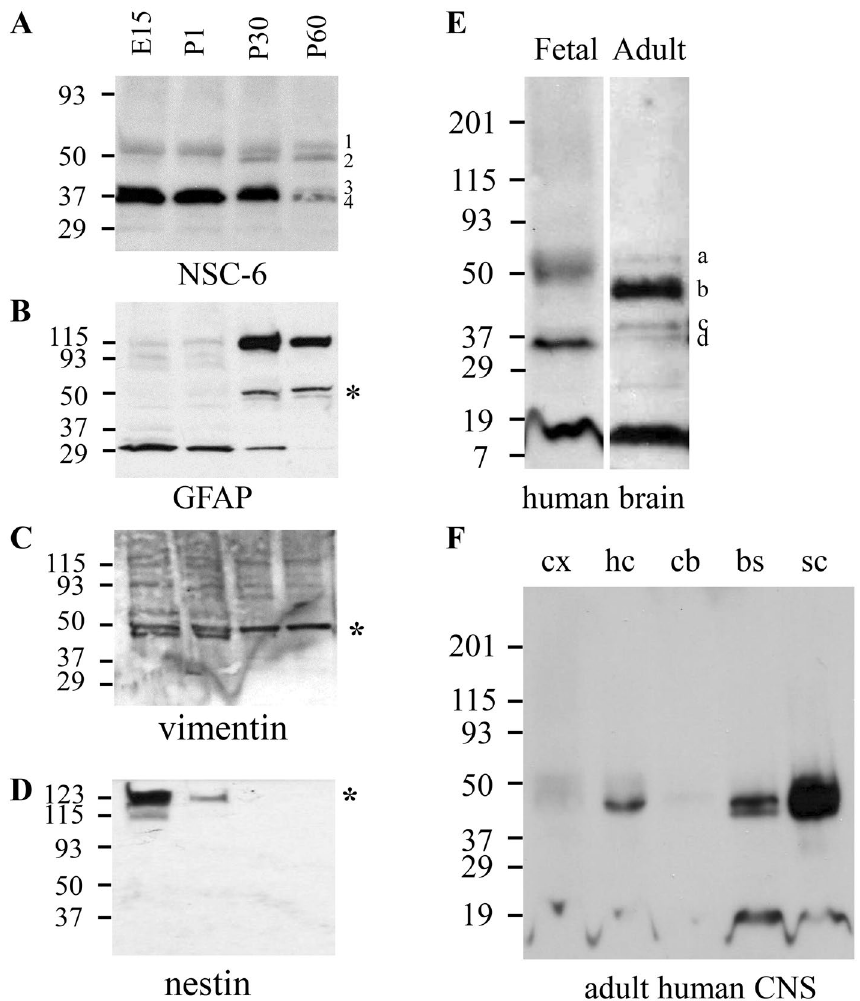
Figure 8. Immunoblot analysis of NSC-6 immunolabeling in developing mammalian brain. ( A ) NSC-6 immunoblotting of E15, P1, P30 and P60 mouse whole brain extracts. Four different bands (1–4) and with the respective M r values of 51 kDa, 47 kDa, 38 kDa, and 35 kDa are recognized by the NSC-6 Ab. These distinct species changed through development and maturation. Immunoblots of the same samples probed with antibodies against GFAP ( B ), vimentin ( C ), and Nestin ( D ). The asterisks mark the bands corresponding to the expected M r of these proteins. ( E ) NSC-6 immunoblotting of fetal and adult human brain. Note the distinct pattern of immunolabeling for the four bands a–d, with respective M r values of 51 kDa, 45 kDa, 38 kDa, and 35 kDa, between fetal and adult brain. ( F ) NSC-6 immunoblotting of samples from human cortex (cx), hippocampus (hc), cerebellum (cb), brainstem (bs), and spinal cord (sc). Separate blots from different gels were cropped and separated by white space. Entire blots are not